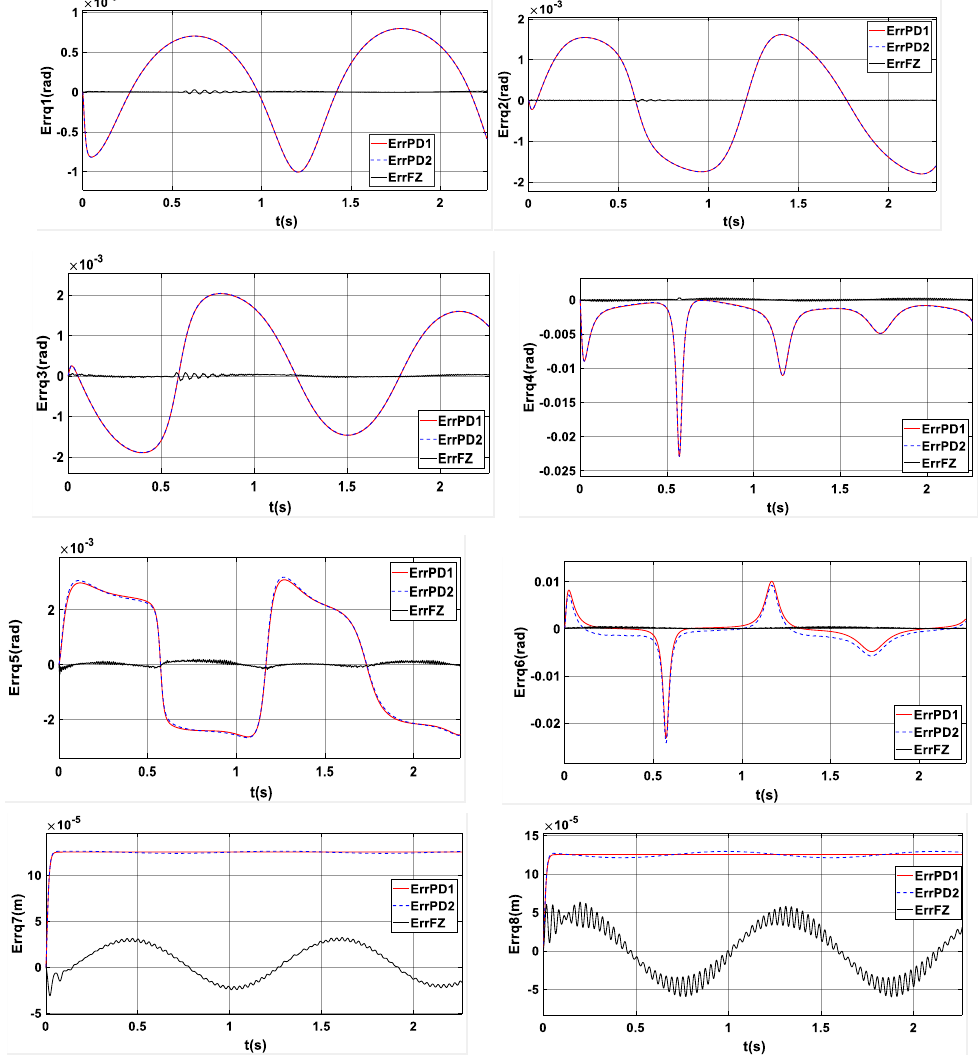
Figure 13. The joint position errors of the PD1, PD2, fuzzy controllers.